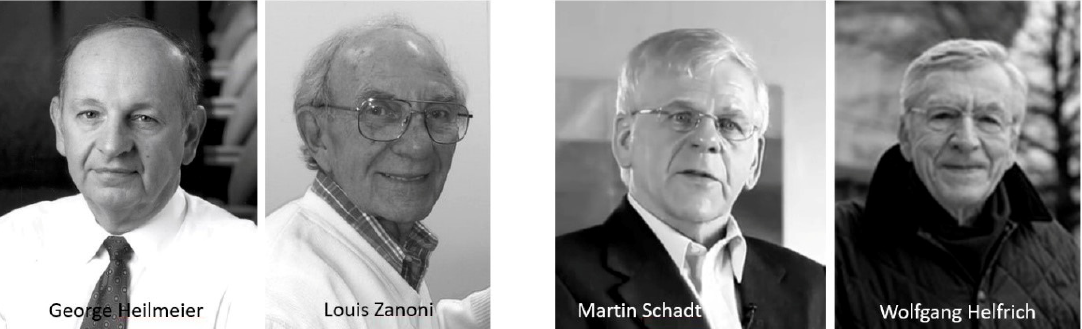
Figure 6. The pioneers of the invention of liquid crystal displays: Heilmeier and Zanoni (dynamic scattering display), as well as Schadt and Helfrich (twisted nematic display).